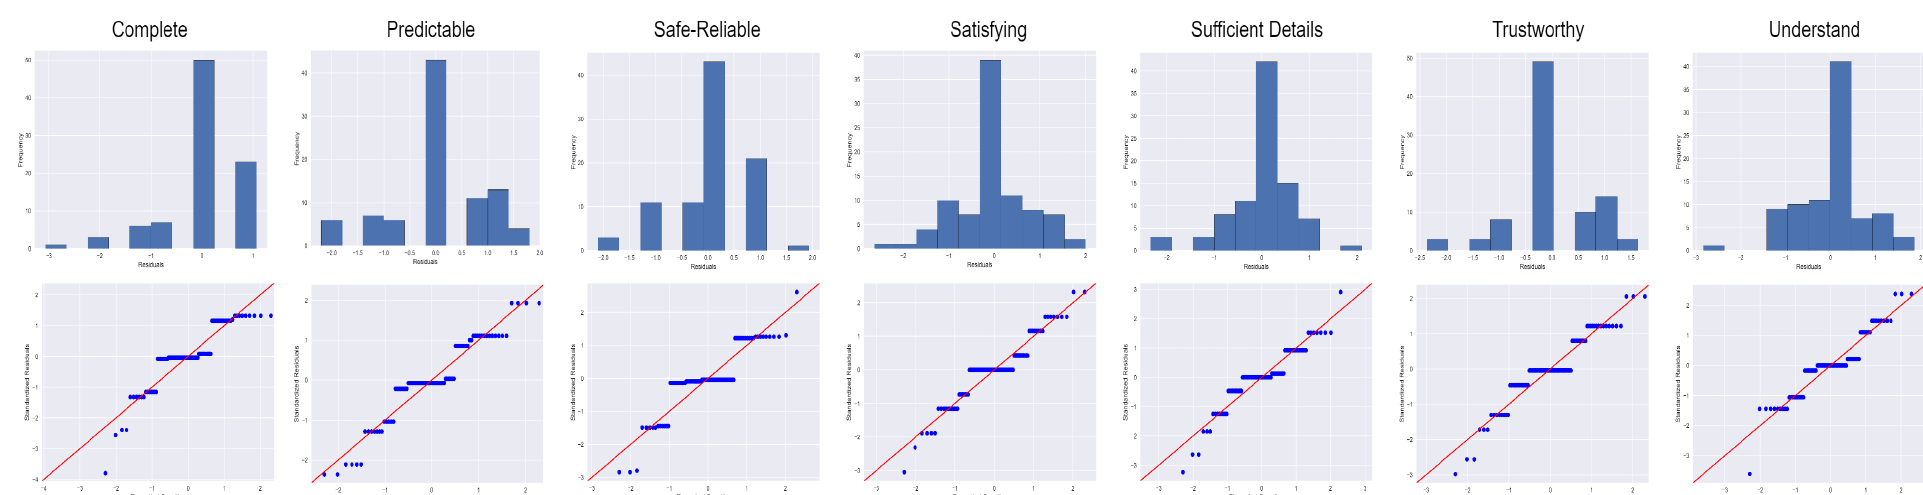
Figure A2. Histograms of the distribution of the residuals and Q-Q plots for each quality of the “Why” explanations.